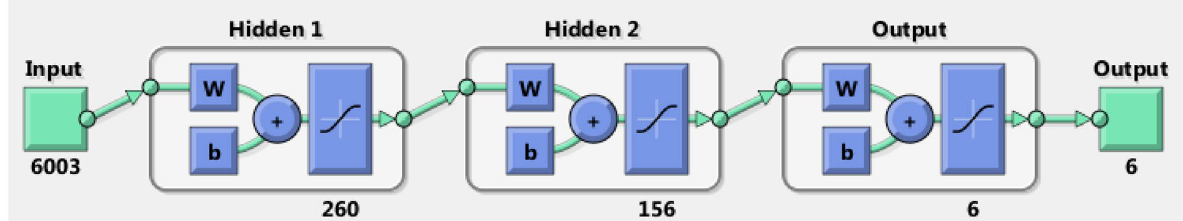
Figure 4. Structure of the two-layer pattern classifier of the first example.